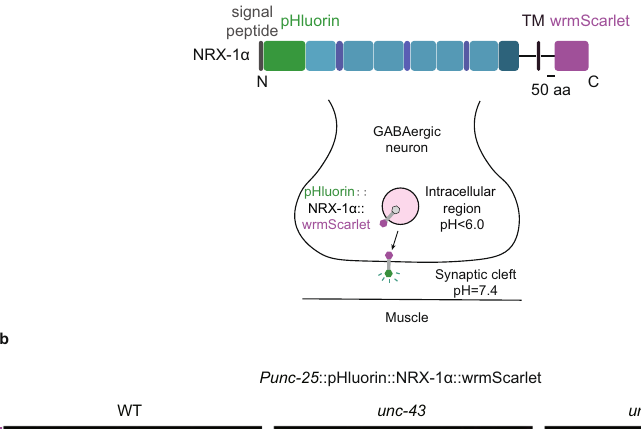
mutants( c ).NRX-1 α -wrmScarletpuncta(magenta) fl uorescenceinthedorsalnerve cordswasunalteredinthe unc-43 mutants( d ).Theaveraged fl uorescenceintensity of pHluorin normalized to wrmScarlet fl uorescence intensity in the unc-43 mutants ( e ). Repres e ntative images (top, scale bar 10 μ m) and mean puncta intensities+/ − SEM(bottom,Nsrepresentthenumberofanimalstested)areshown. One-way ANOVA with post-hoc Bonferroni ’ s multiple comparison test for c , d , Kruskal – Wallis test with post-hoc Dunn ’ s test for e . *** p <0.001, n.s. not sig- ni fi cant. For c – e , source data are provided as a Source Data fi